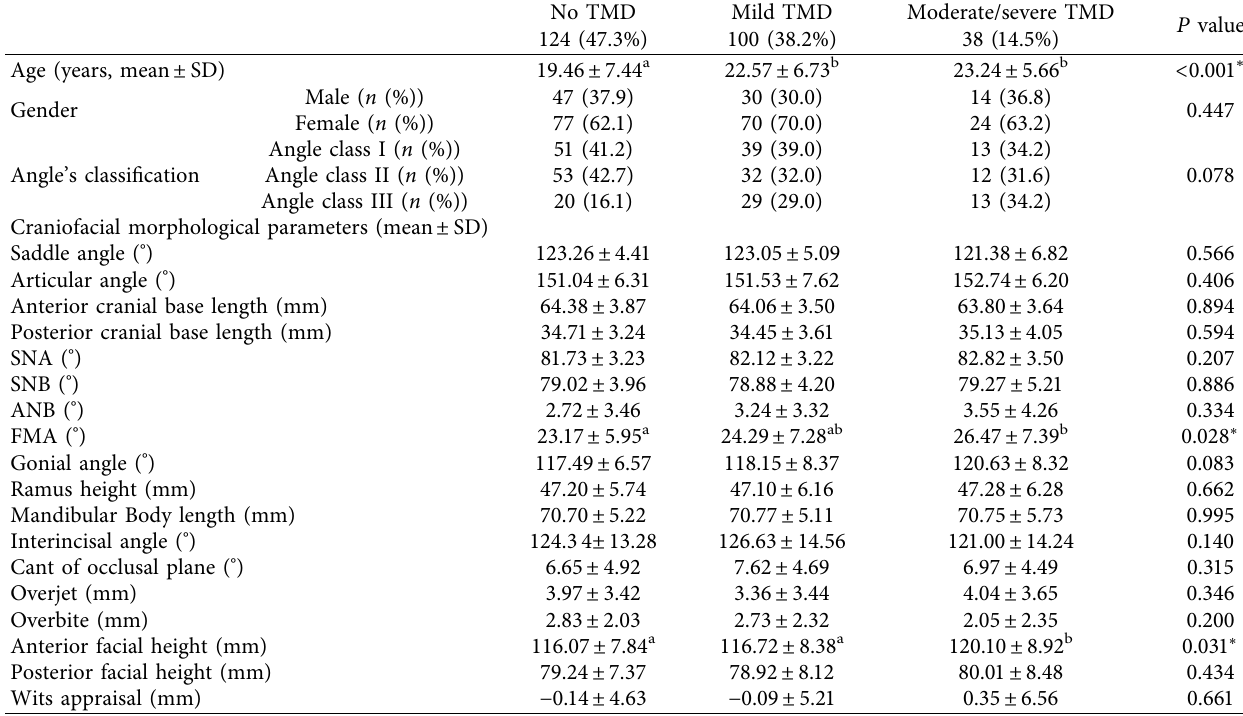
Table 3: Comparison of demographic, occlusal, and craniofacial morphological characteristics among patients with no, mild, and moderate/ severe TMDs.